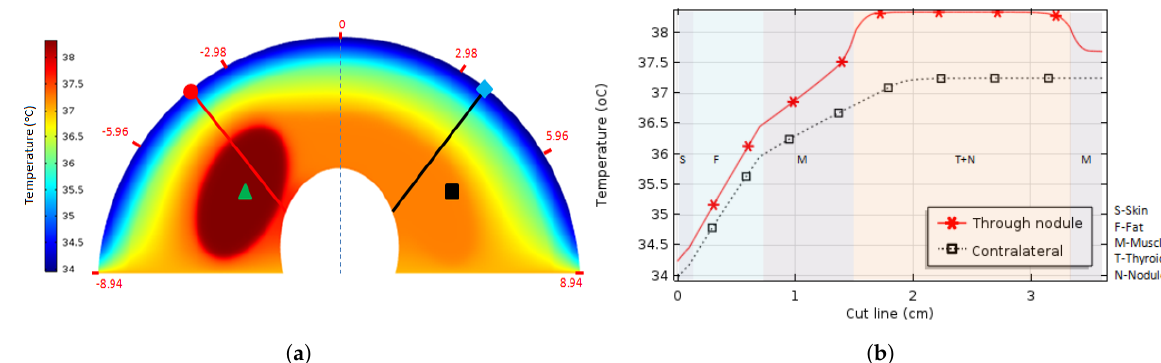
Figure 7. Temperature variations inside the neck represented in colors ( a ) and graphically along symmetrical lines ( b ). They are computed by finite element simulation considering a big elliptic nodule (17.76 cm 2 ) and a medium fat tissue layer (thickness of 0.6 cm). Both (red and black) lines represent the temperature going from the surface to the trachea: They cross the skin (S), fat (F), muscle (M), and thyroid (T) layers represented by the smooth colors. The red line goes through the nodule (N) as